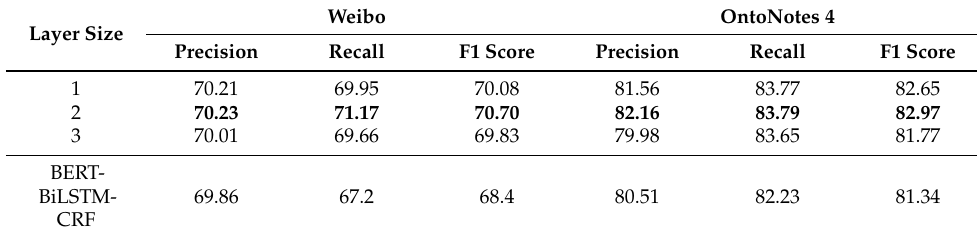
Table 8. Performance of CGR-NER under different crossmodal attention layers. Layer